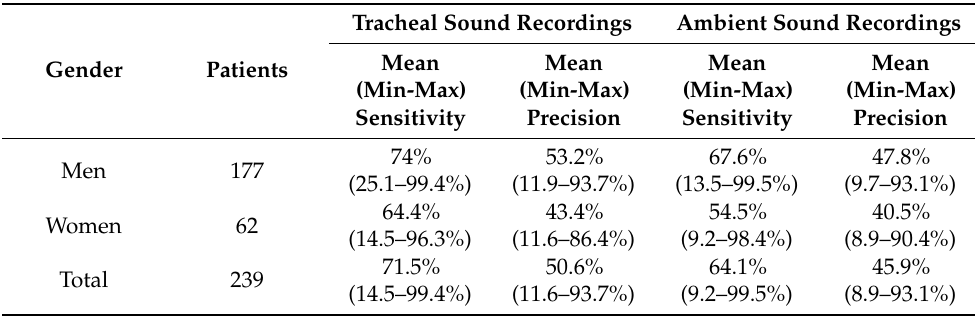
Table 4. The sensitivity and precision per patient with the additional information of paitent gender to examine the performance of the developed algorithm in the different gender